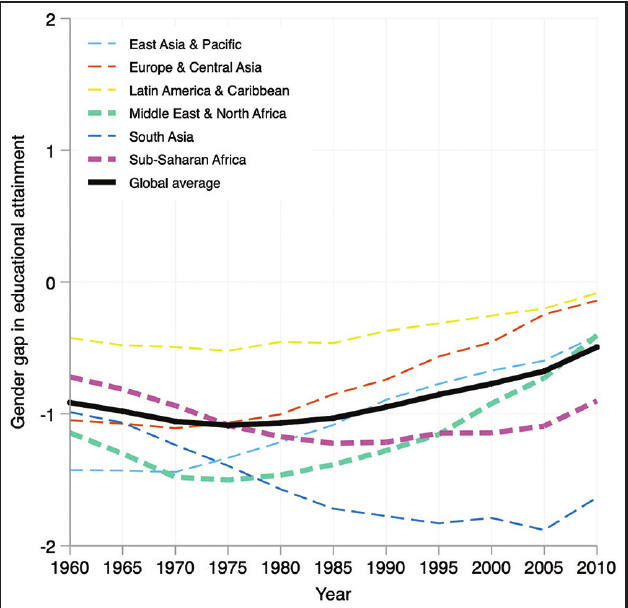
Regional Change in Gender Gaps in Average Schooling Years,